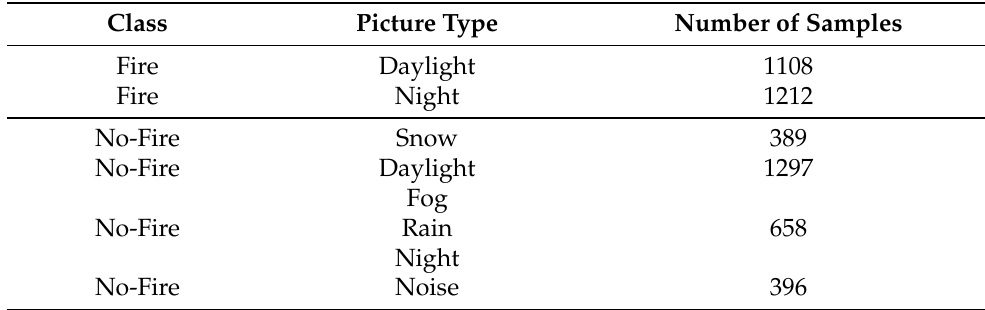
Table 2. Picture dataset